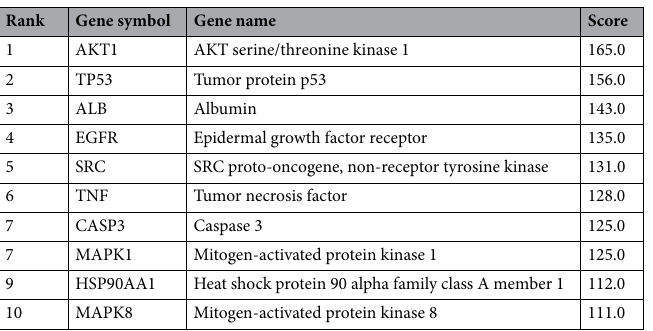
TP53 – EGFR , ALB – SRC , and TNF – CASP3 (Table 2). A pathway enrichment analysis revealed that several path- ways are affected by the observed genetic alterations, including RTK-RAS, TP53, PI3K, and cell cycle pathways (Supplementary Table 5). The RTK-RAS pathway was detected in two queries, EGFR and MAPK1 , as well as neighboring genes, including members of the ERBB family, RAS family, and RAF family, which are involved in cellular processes including proliferation, cell survival, and translation (Fig. 4C). Copy number alterations in ALB, SRC , and TNF were not obvious (Fig. 4D). In AKT1 , significant differences in mRNA levels were found between alteration types (i.e., shallow deletion, diploid, and gain); in particular, the expression of AKT1 was highest in cases with copy number gain, followed by diploid, and shallow deletion. The mRNA levels of TP53 in the shallow deletion group were significantly lower than those in the diploid and gain groups. In EGFR , we found that mRNA expression levels in the case of amplification were significantly higher than that those in the diploid and gain groups. mRNA levels of CASP3 and MAPK8 in diploids were significantly higher than those in the shallow deletion group. In addition, mRNA levels of MAPK1 and HSP90AA1 were significantly higher in the case of gain than in the diploid and shallow deletion groups. We then evaluated TP53 and EGFR mutations across patient samples in Liu et al. (2018). We found several mutations in TP53 in the p53 tetramerization domain, p53-DNA binding domain, and p53 transactivation domain (Fig. 4E). EGFR mutations occurred in many domains, such as the receptor-ligand domain, furin-like cysteine-rich region, growth factor receptor domain IV, and protein tyrosine kinase domain (Fig. 4F). Expression of hub genes in glioblastoma samples. The mRNA levels of the hub genes AKT1, TP53, EGFR, and CASP3 were significantly higher in patients with GBM than in normal brain tissues (Fig. 5A). In addition, mRNA levels of ALB, SRC, TNF, MAPK1, HSP90AA1, and MAPK8 were not statistically significant between GBM and normal brain tissues. Survival analysis of hub genes. The prognostic value of each hub gene was analyzed using a Kaplan– Meier plot. Among the hub genes, only ALB and MAPK8 levels were significantly associated with the survival of patients with GBM (Fig. 5B). Patients with low levels of ALB had a better overall survival than that of patients in group with high expression ( p = 0.0223), whereas patients with high levels of MAPK8 had a better overall survival than that of patients with low expression levels ( p = 0.0416). Correlation between immune cell infiltration and hub genes. We explored correlations between the expression of hub genes and levels of immune cell infiltration in GBM using the TIMER 2.0 database (Table 3, Supplementary Fig. 1). We selected only four hub genes, AKT1, TP53, EGFR, and CASP3 , based on their high expression levels in GBM, as analyzed by GEPIA. The expression levels of AKT1 ( r = 0.311; p = 2.06 × 10 −4 ), TP53 ( r = 0.311; p = 7.36 × 10 −5 ), EGFR ( r = 0.288; p = 6.15 × 10 −4 ), and CASP3 ( r = 0.232; p = 6.24 × 10 −4 ) were signifi- cantly and positively correlated with purity. Only CASP3 was significantly negatively correlated with B cells ( r = −0.181; p = 3.44 × 10 −2 ). The expression of CD8 + was significantly negatively correlated with the levels of AKT1 ( r = −0.318; p = 1.53 × 10 −4 ) and EGFR ( r = −0.142; p = 9.75 × 10 −2 ). CD4 + levels were significantly positively correlated with the levels of AKT1 ( r = 0.187; p = 2.87 × 10 −2 ), TP53 ( r = 0.192; p = 2.49 × 10 −2 ), and EGFR ( r = 0.195; cantly positively correlated with levels of AKT1 ( r = 0.266; p = 7.85 × 10 −3 ) and TP53 ( r = 0.248; p = 3.42 × 10 −3 ). Dendritic cells showed significant positive correlations with levels of AKT1 ( r = 0.439; p = 8.24 × 10 −8 ), TP53 ciated fibroblasts (CAFs) showed significant positive correlations with levels of AKT1 ( r = 0.211; p = 1.34 × 10 −2 ), TP53 ( r = 0.211; p = 1.35 × 10 −2 ), and CASP3 ( r = 0.226; p = 7.88 × 10 −3 ).